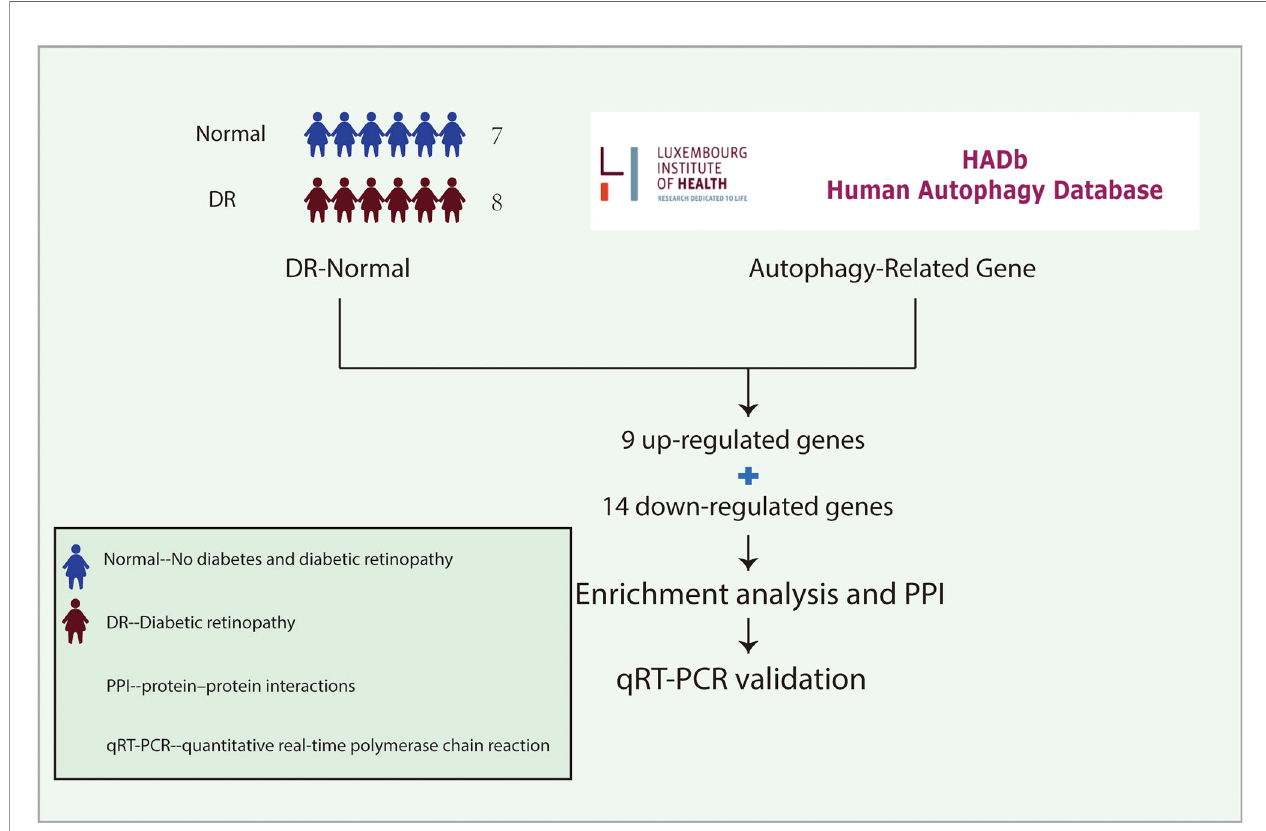
FIGURE 1 | The idea of experimental design. The gene expression pro fi les of LCLs extracted from the peripheral blood of 7 non-diabetic individuals and 8 patients with DR were cultured under SG and HG conditions respectively in the GSE146615 dataset. 232 autophagy-related genes were collected from The Human Autophagy Database. Then, 9 up-regulated genes and 14 down-regulated genes were screened by differential analysis. After enrichment analysis and PPI network construction, 10 hub genes were identi fi ed. Finally, qRT-PCR was used to verify in vitro DR model. LCLs, lymphoblastoid cell lines; DR, diabetic retinopathy; SG, standard glucose; HG, high glucose; PPI, protein-protein interaction; qRT-PCR, quantitative real-time polymerase chain